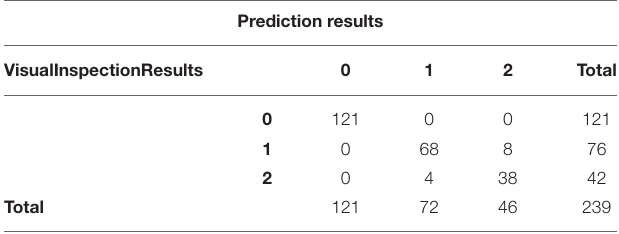
TABLE 3 | Crosstab of the predicted results and the doctor’s visual inspection results. Prediction results